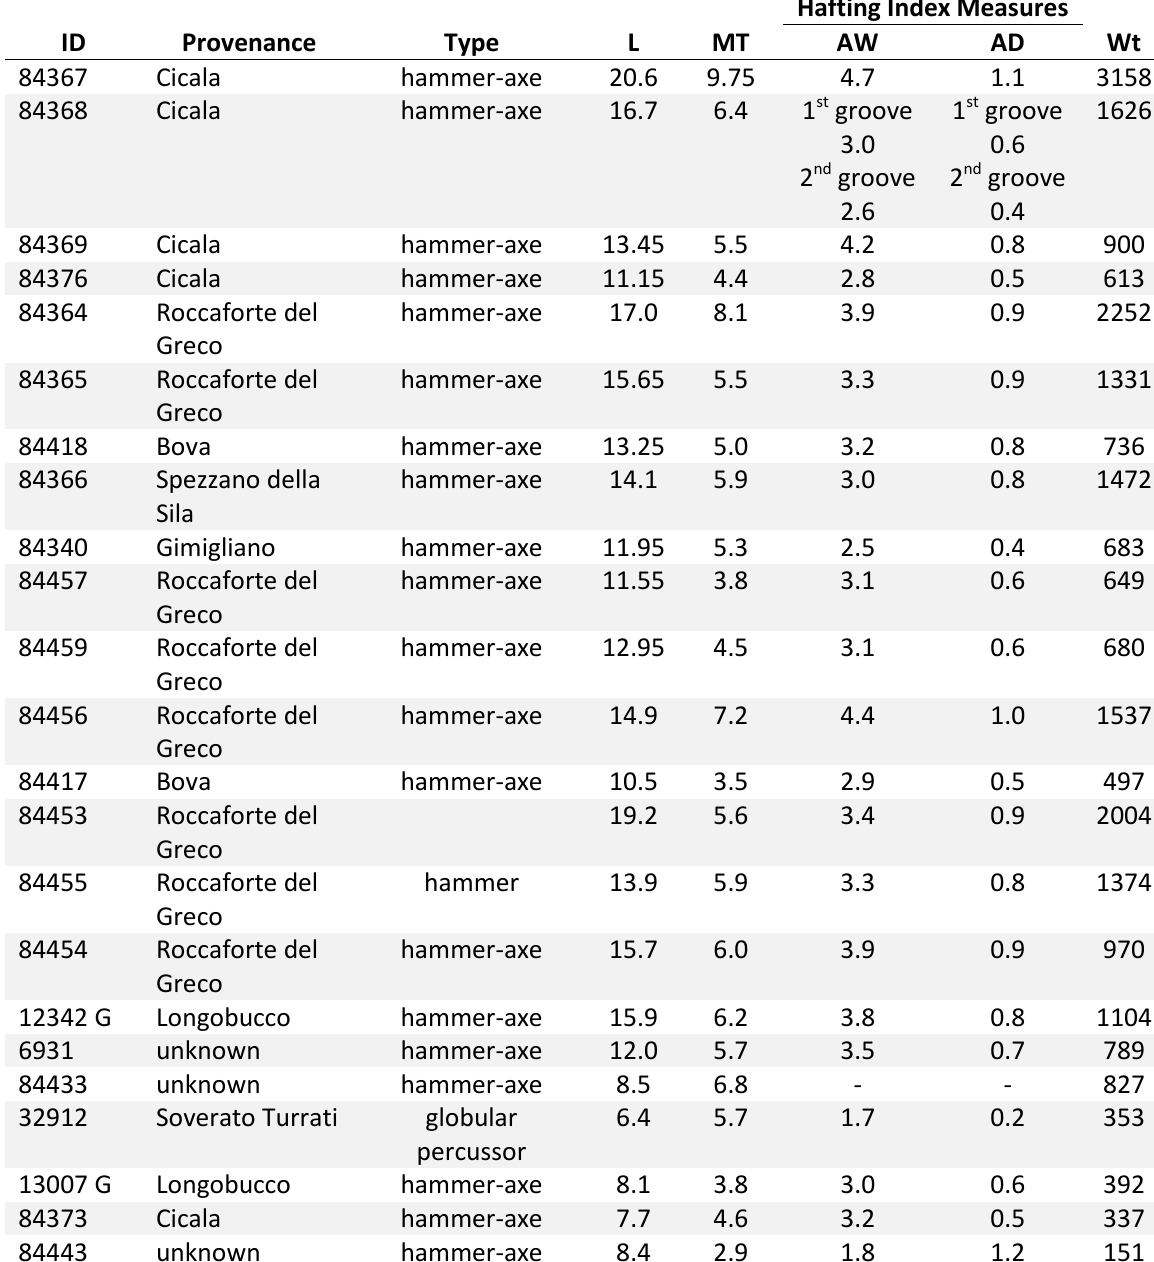
Table 2. ID and quantitative data of the twenty-three grooved tools kept in the Museo Nazionale Preistorico Etnografico “Luigi Pigorini” in Rome. Abbreviations: L - length (cm); MT - maximum thickness (cm); AWd - average width (cm); AD - average depth (cm); Wt - weight